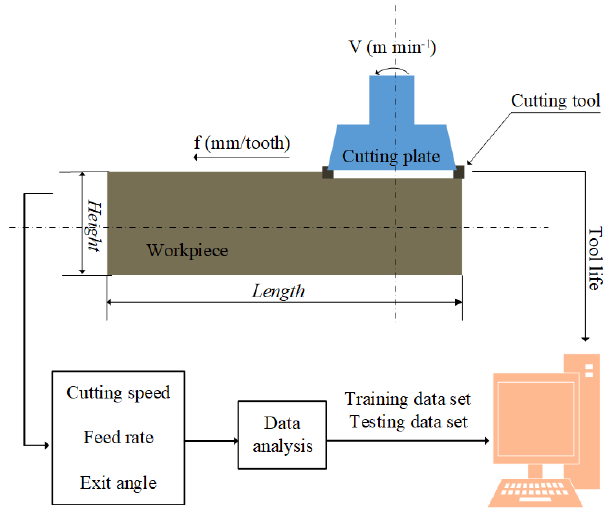
Figure 1. Process of obtaining training and testing